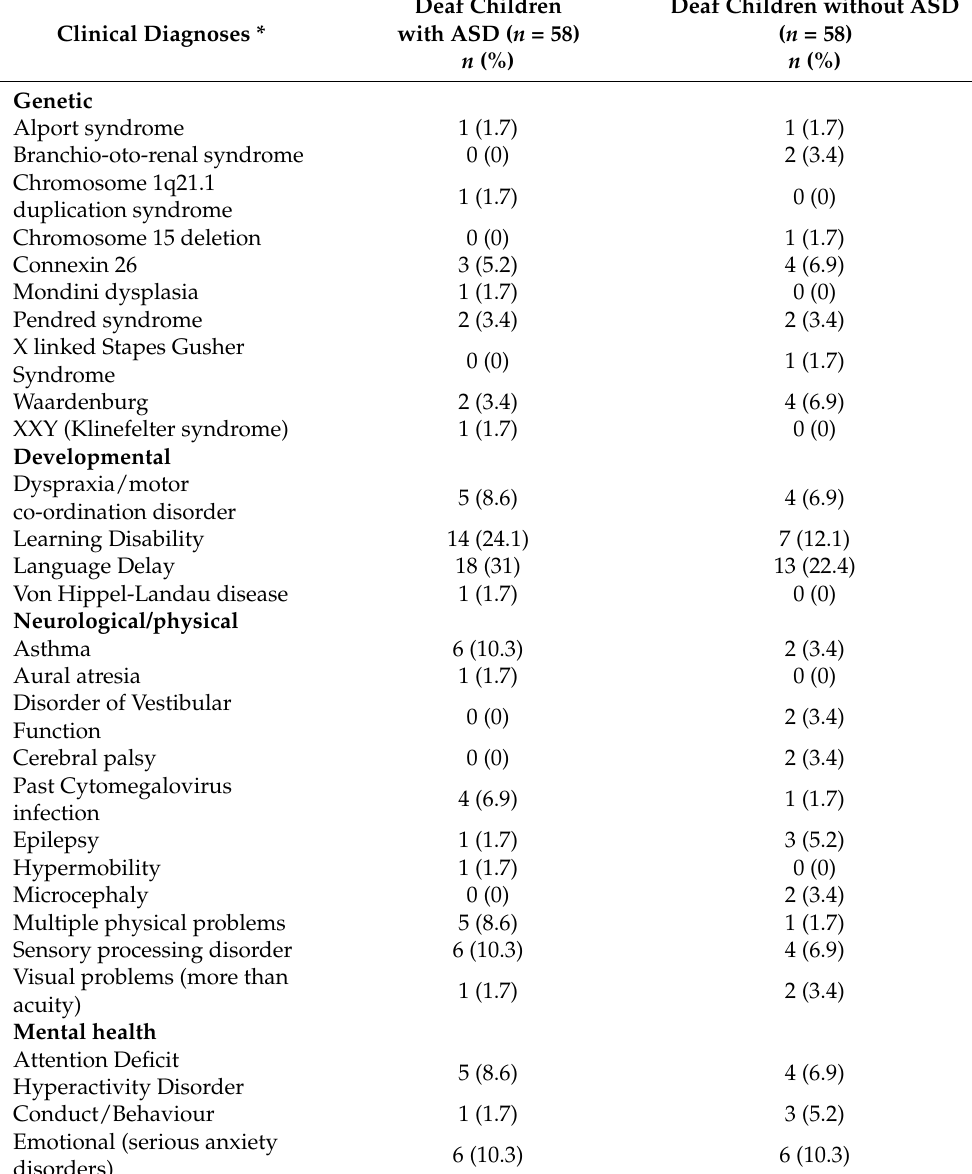
Table 1. Co-morbidities of participants in combined use of ADOS-2 Deaf adaptation and ADI-R Deaf adaptation validation